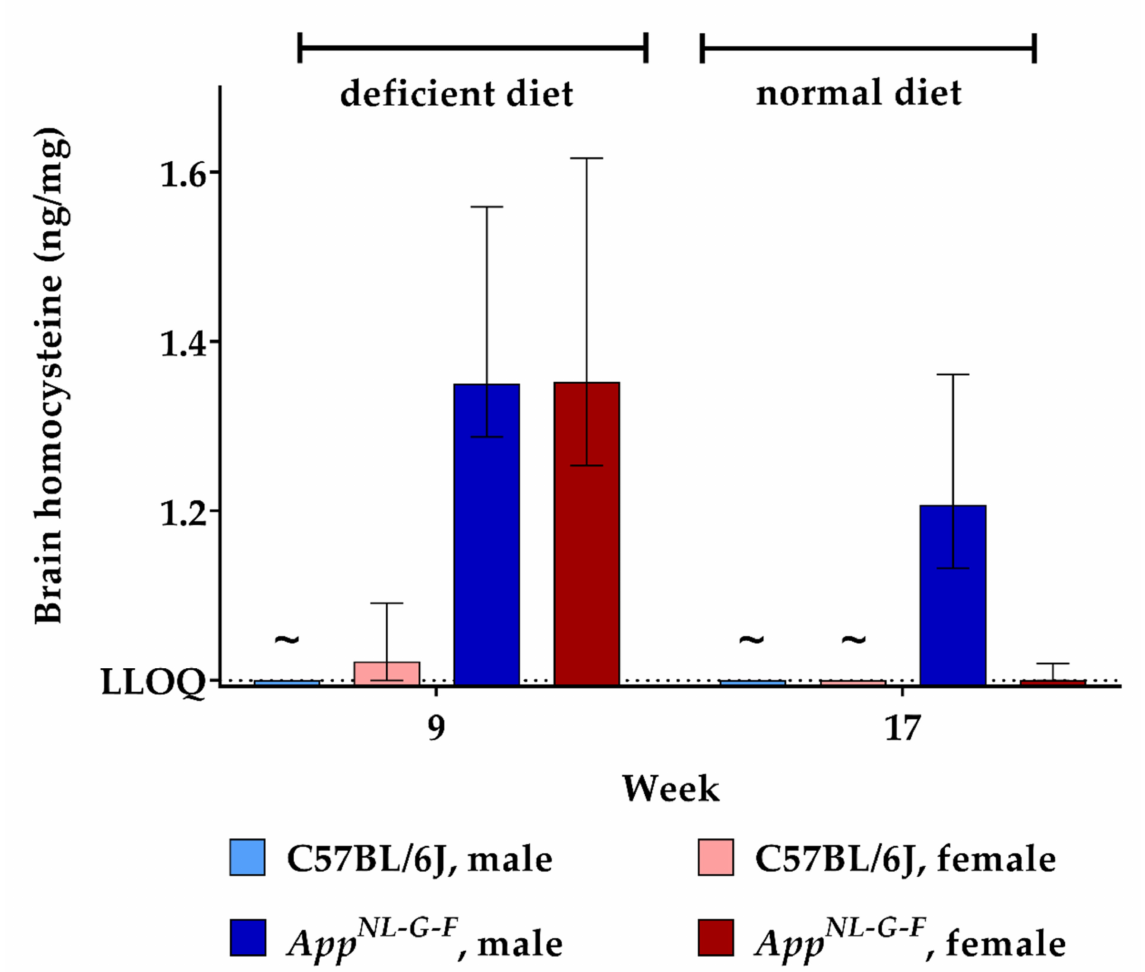
Figure 5. Homocysteine levels in brain tissue in C57BL/6J wild type and App NL-G-F knock-in mice, data are depicted for males and females separately for experimental week 1–17: baseline measurement (w. 1), diet deficient in vitamin B6, B12 and folate (for 8 w.), balanced normal chow (for 8 w.); all brain samples were analyzed using a combination of liquid chromatography with tandem mass spectrometry and statistically tested non-parametrically using the Kruskal-Wallis test; data are presented as median ± interquartile range (IQR); extreme outliers beyond 3xIQR have been excluded; ~indicates levels below the lower limit of quantification